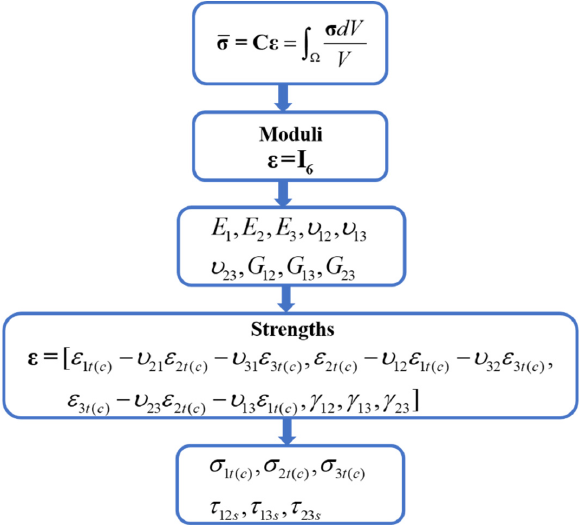
Figure 4. Program of applying periodic boundary conditions for determining elastic properties and strength properties.